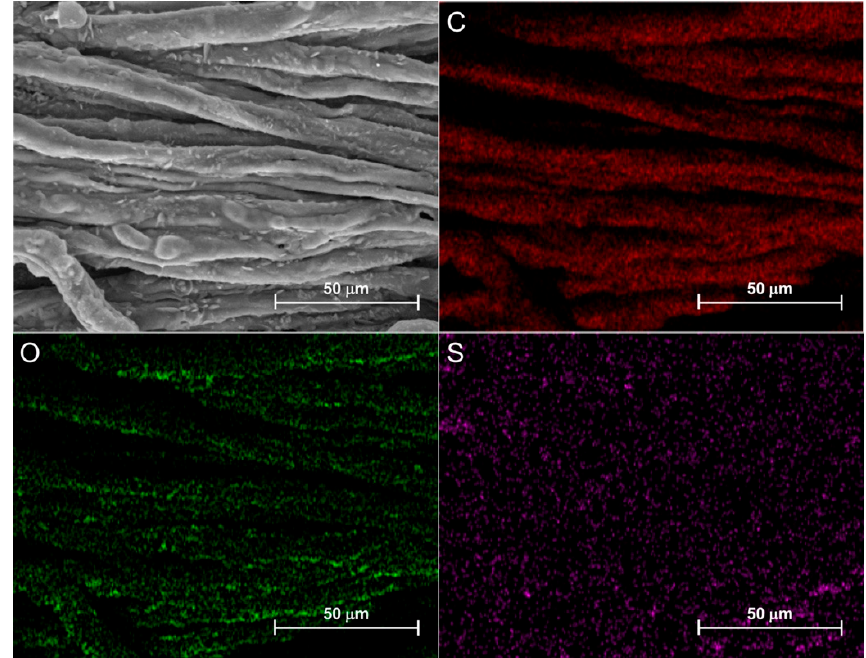
50 –C 50 residue after horizontal flame spread tests. Polymers 2019 , 11 , x FOR PEER REVIEW